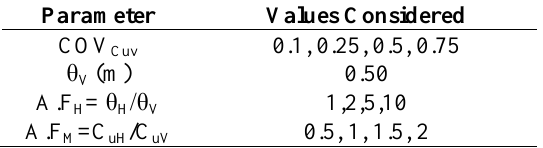
Table 3. Parameters in stochastic bearing capacity analyses of shallow